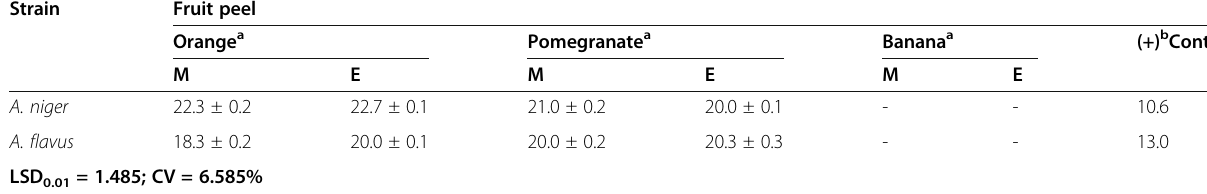
Table 3 Inhibition zones of both methanolic and ethanolic extracts of the used fruit peels against some fungal food pathogens